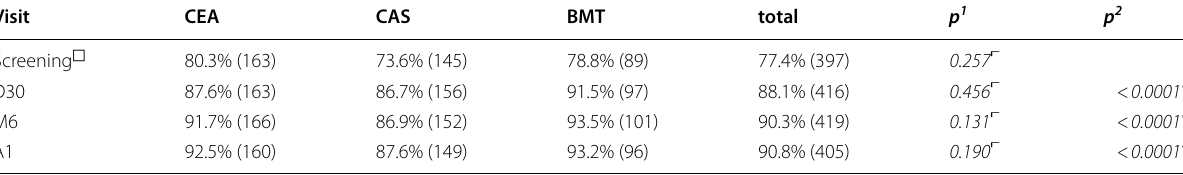
Table 3 Proportion of patients on statin medication in each study group over time; n